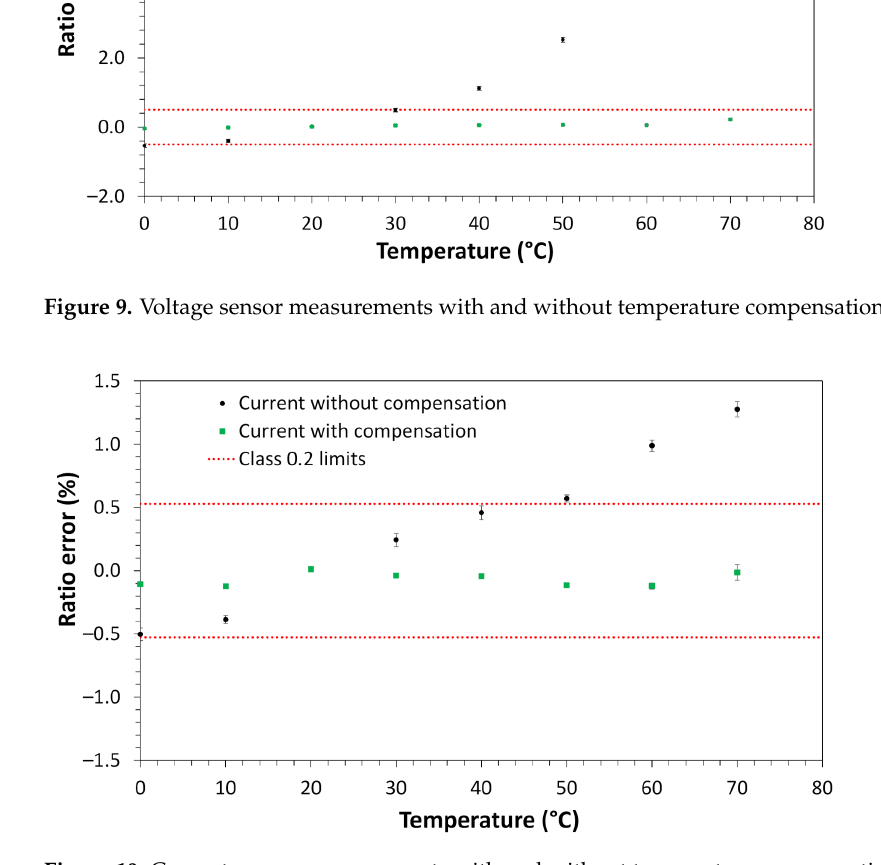
Figure 10. Current sensor measurements with and without temperature